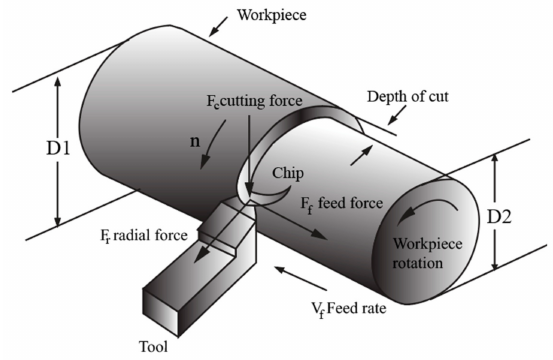
Figure 1. Turning process